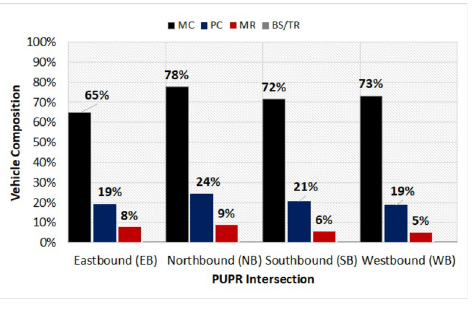
Fig 4. Vehicle composition at PUPR intersection.